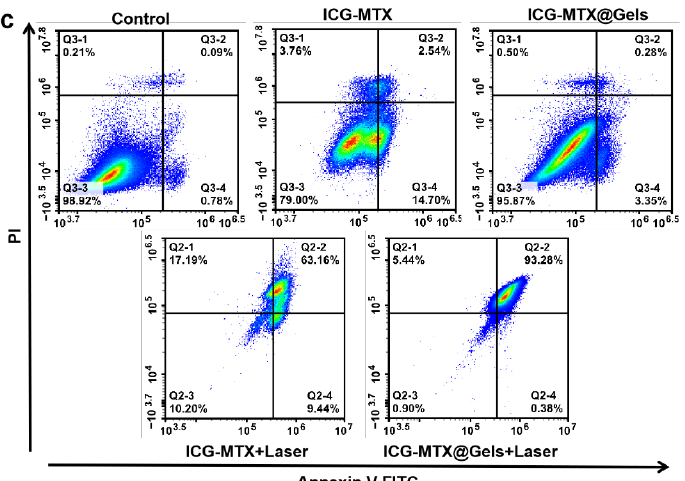
Figure 9. The survival of Hela cells cultured with ICG—MTX or ICG—MTX@PPA Gels for 24 h with